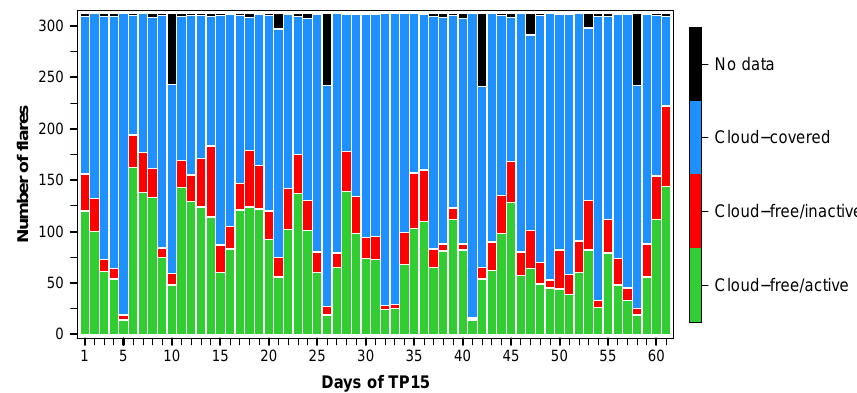
Figure 6. Number of flares per day in TP15 that are cloud-free and active (green), cloud-free and inactive (red) and cloud-covered (blue). Flares with no or incomplete data are denoted in black. The color coding follows Fig. 4b. Considered are the 312 flares that deliver at least once a value for T s and H in TP15.